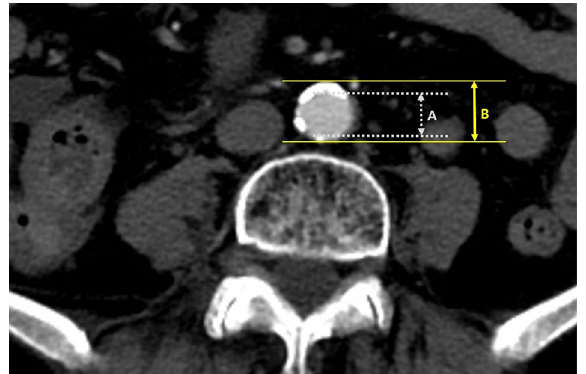
Figure 3. Measurement of the degree of stenosis. The degree of stenosis was calculated using the formula, (B − A)/B ×